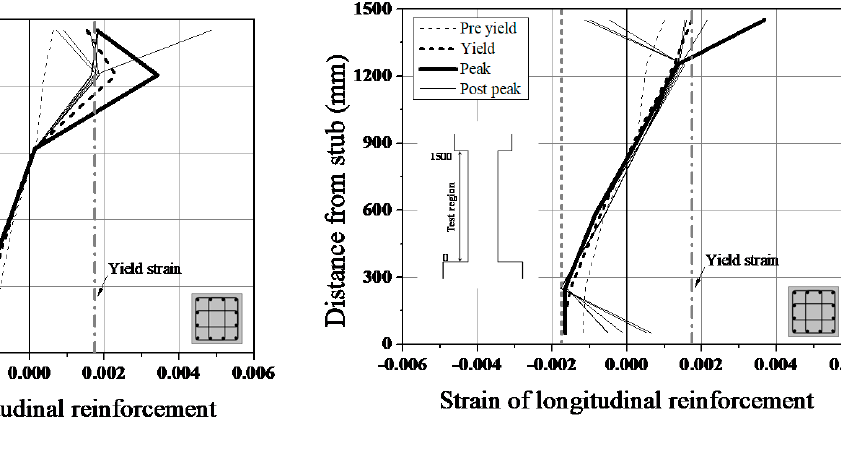
Figure 6. Failure mode of specimens: ( a ) NH20; ( b ) NH30; ( c ) UH20; ( d ) UH30; ( e ) NS20; ( f ) NS30; ( g ) US20; ( h )